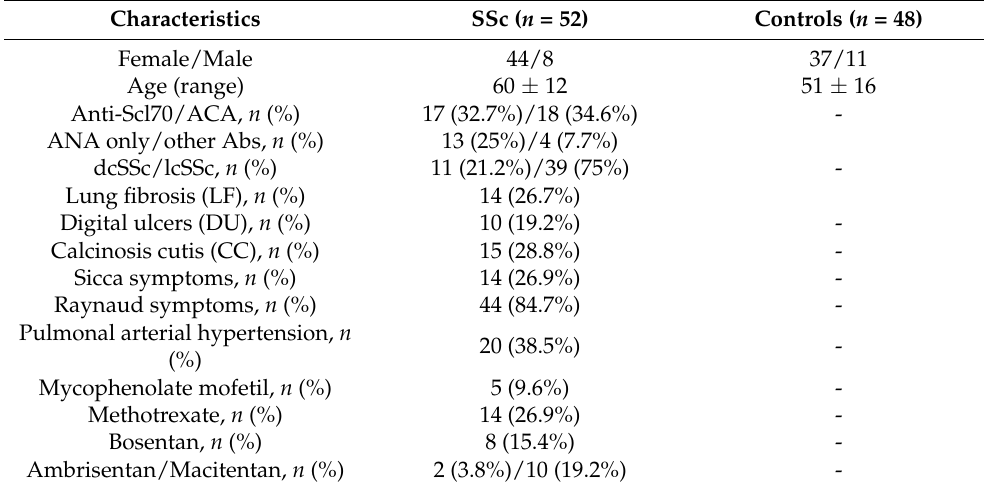
Table 1. Demographic and clinical characteristics of patients with systemic sclerosis (SSc) and controls.